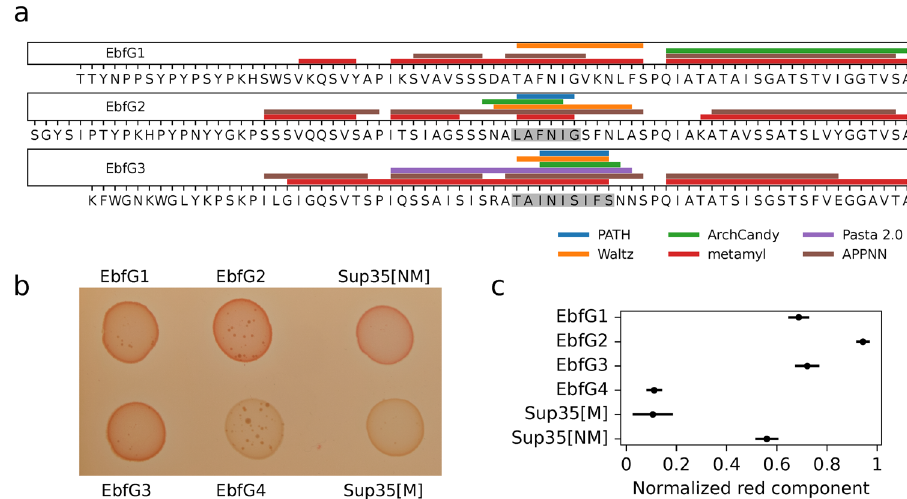
Fig. 6 Amyloid prediction and heterologous expression of EbfG1-4 proteins. a Prediction of amyloidogenic hotspots in the sequences of EbfG1-3 using six software prediction tools. Shaded fragments correspond to consensus positive prediction in at least four of the predictors. b Colony color phenotype of EbfG-expressing Escherichia coli compared to negative (Sup35[M]) and positive (Sup35[NM]) controls for amyloid formation in inducing plates. c Normalized red component of the brim of each colony as analyzed in ImageJ, based on fi ve biological replicates and displayed as the mean and 95% con fi dence interval (t